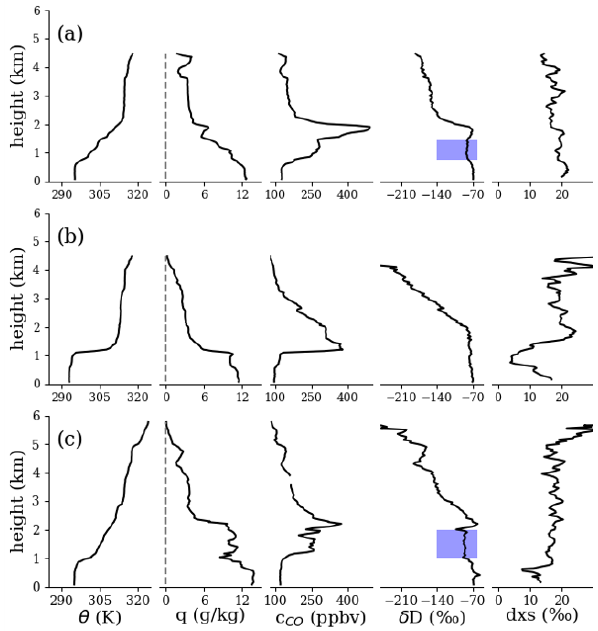
Figure 10. Similar to Fig. 9 but for the 2017 sampling period. (a, b) Two vertical profiles taken on 15 August: (a) mean latitude 4 ◦ S, mean longitude 4.95 ◦ E, mean time 15:16UTC; (b) 8.4 ◦ S, 5.0 ◦ E, 13:50UTC. (c) One profile from 26 August (5.2 ◦ S, 5.0 ◦ E, 11:17UTC). Blue highlighted regions are discussed in the main text.